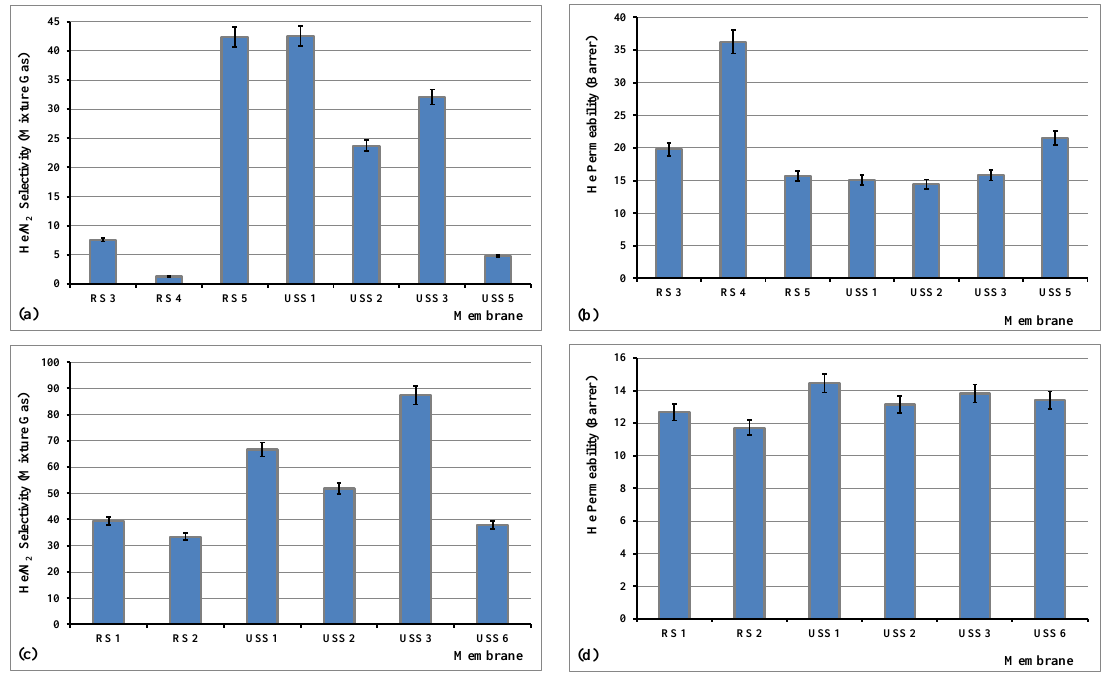
Figure 14. Selectivity of He/N 2 gas mixture and permeability of helium at dP of 1.33 bar and 28 °C ( a , b ), and selectivity of He/N 2 gas mixture and permeability of helium at dP of 5 bar and 28 °C ( c , d ).